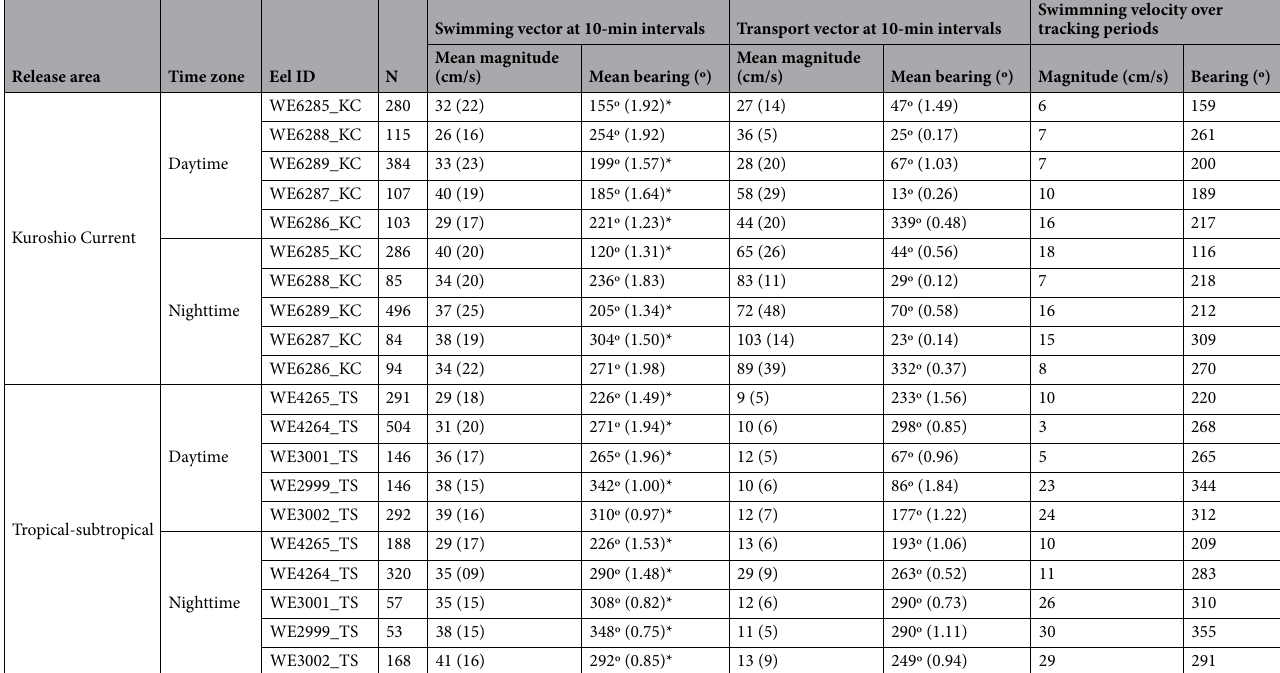
Table 2. Summary of swimming and transport vectors obtained at 10-min intervals in the acoustic tracking of ten Japanese eels. Values in parenthesis indicate standard deviations. Asterisk(*) in the bearing of the swimming vector indicates a significant difference from the uniformity of a circular distribution by the Rayleigh test ( P < 0.05).